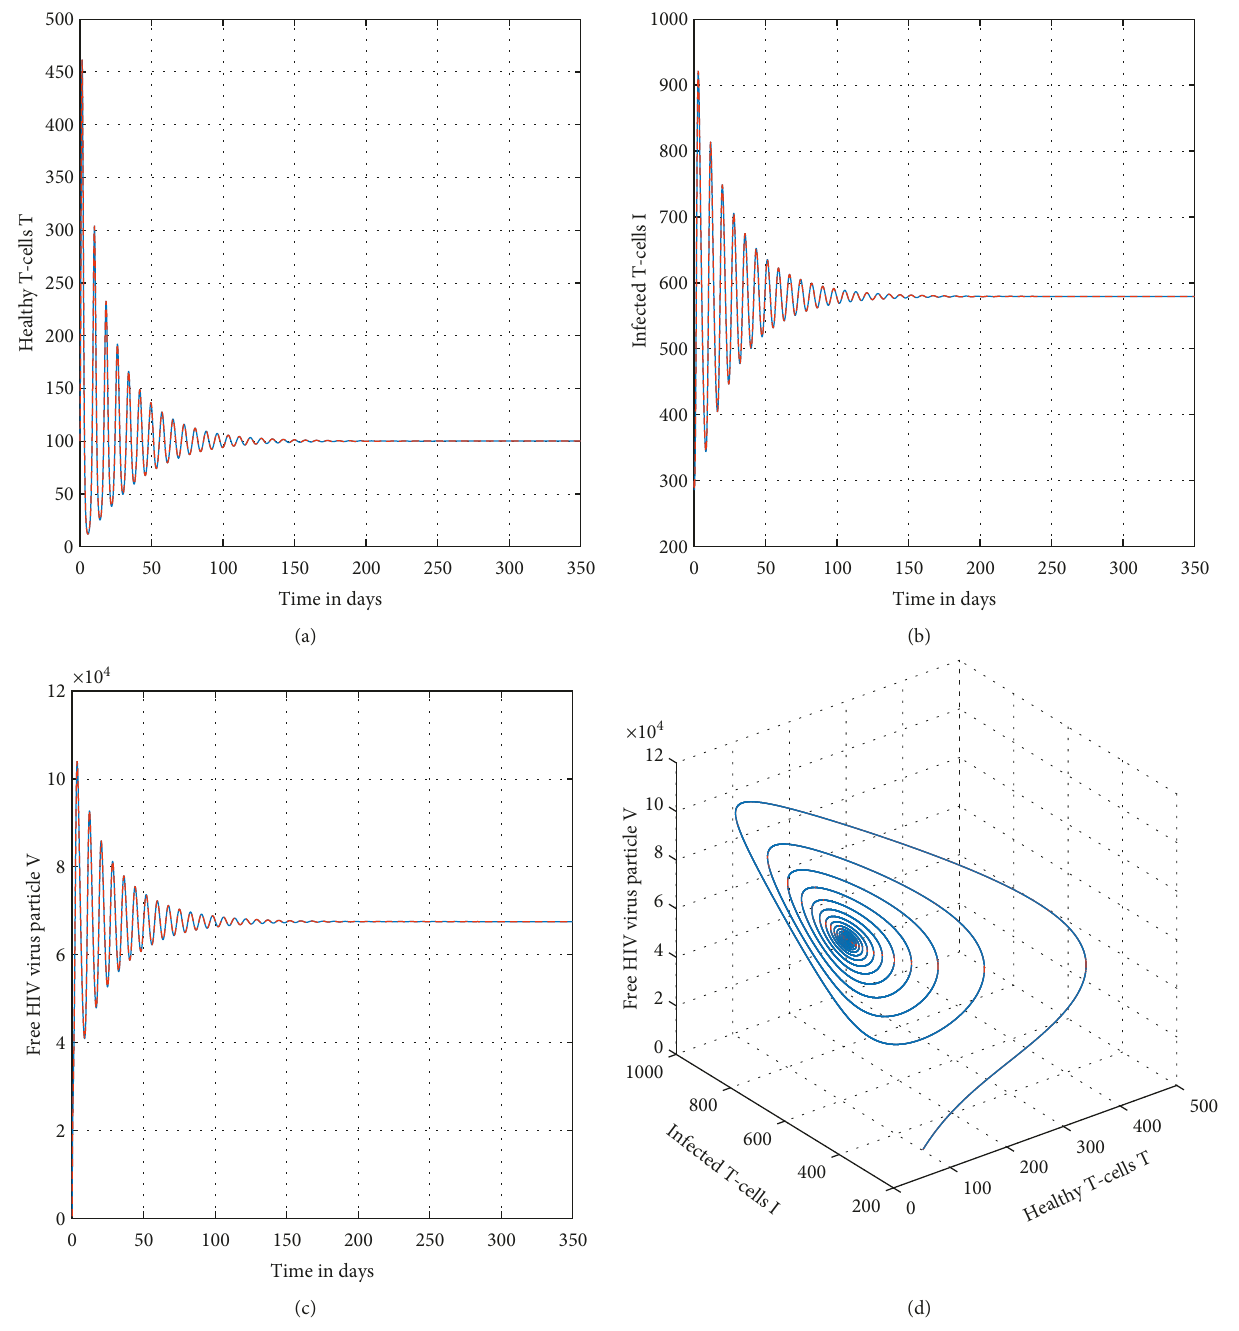
Figure 4: Graphical view analysis of the fractional model (2) of HIV by taking the index of memory ϑ � 1 .